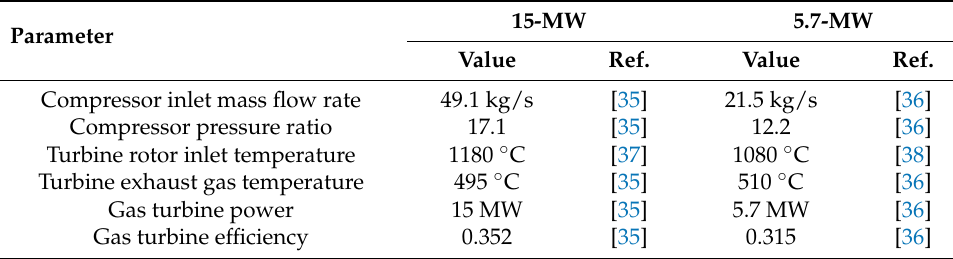
Table 1. Design parameters and performance of the 15-MW and 5.7-MW gas turbines.